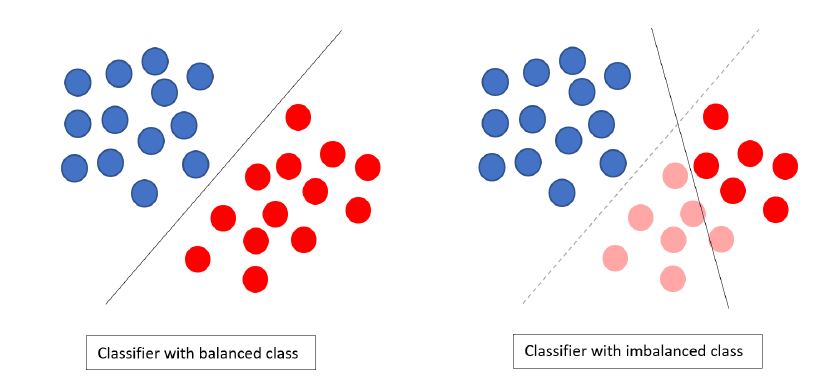
Figure 8. General representation of the problem of classifier trained with imbalance class.